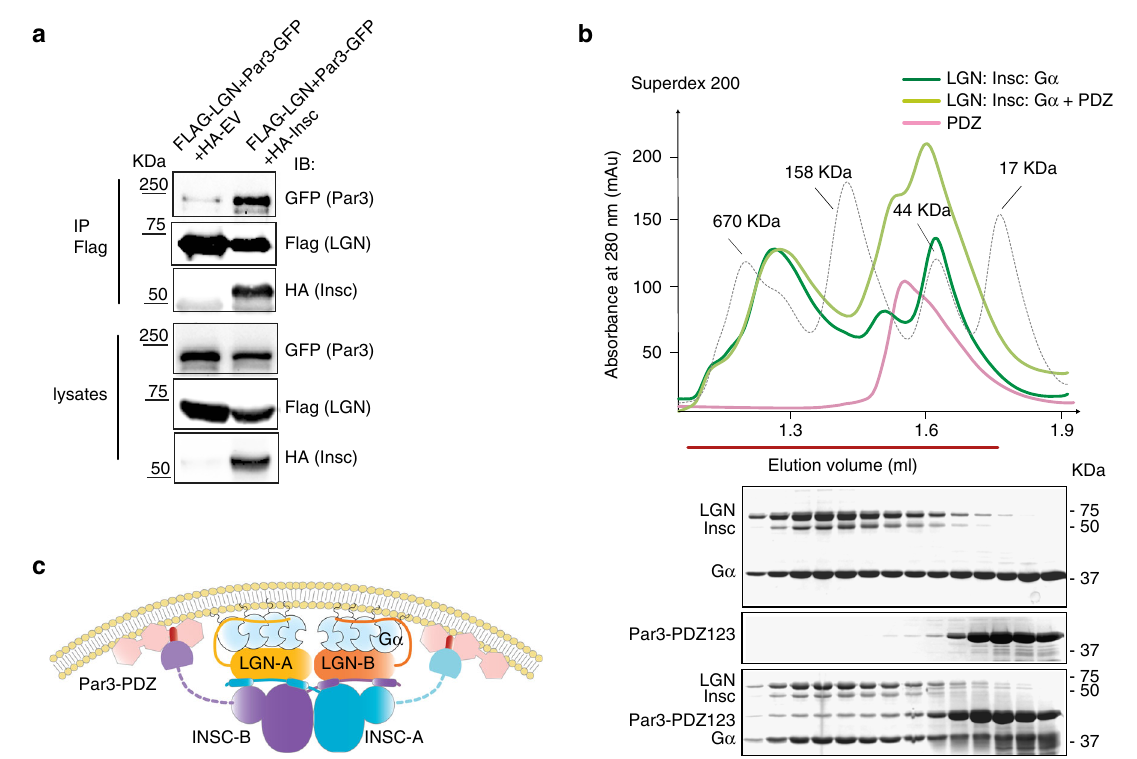
Fig. 4 Conserved organizational principles of Par3:Insc:LGN:G α i complexes. a Reconstitution of human Par3:Insc:LGN interaction in cells. HEK293T cells were transfected with Par3-GFP, FLAG-LGN and HA-Insc. Cell lysates were subjected to IP with α -FLAG antibody conjugated to sepharose beads. After washes, species on beads were analyzed by SDS – PAGE and immunoblotted as indicated in the fi gure. HA-empty vector was included as a negative control of the IP. b SEC elution pro fi les and SDS – PAGE separation of Insc:LGN:G α i complexes reconstituted from expression in insect cells (dark green trace) and Par3 PDZ123 puri fi ed from bacterial sources (pink trace). When the Par3 PDZ123 is mixed in molar excess with Insc:LGN:G α i, it coelutes with Insc:LGN:G α i in a stoichiometry re fl ecting the amount of Insc in the complex (light green trace). c Summary of the interactions in the Par3:Insc:LGN:G α i complex supported by our study. Stable Insc:LGN tetramers form the core of apically localized Par3:Insc:LGN:G α i complexes, in which the C-terminal portion of the two Insc chains contacts directly the PDZ domains of Par3. Binding of each LGN-GoLoco to four G α i GDP molecules stabilizes the association of the